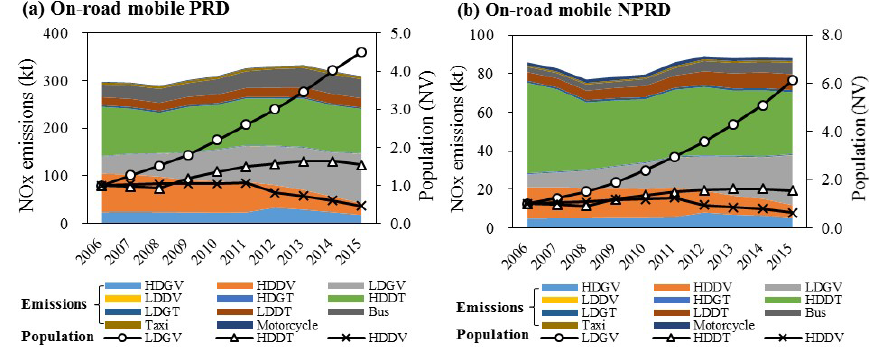
Figure 7. Trends of NO x emissions from the on-road mobile source (left axis) and its activity data (right axis) from 2006 to 2015 in (a) PRD and (b) NPRD. Emissions are presented by sub-category in the on-road mobile